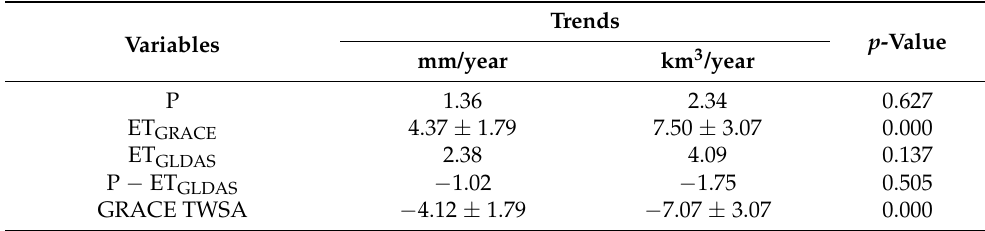
Figure 10. The variations in P, ET GRACE , ET GLDAS ( a ), P − ET GLDAS , and GRACE TWSA ( b ) of the Aral Sea Basin over the period of 2002–2017. The black bars represent the data uncertainty. Table 6. Trends in P, ET GRACE , ET GLDAS , P − ET GLDAS , and GRACE TWSA of the Aral Sea Basin during the period of